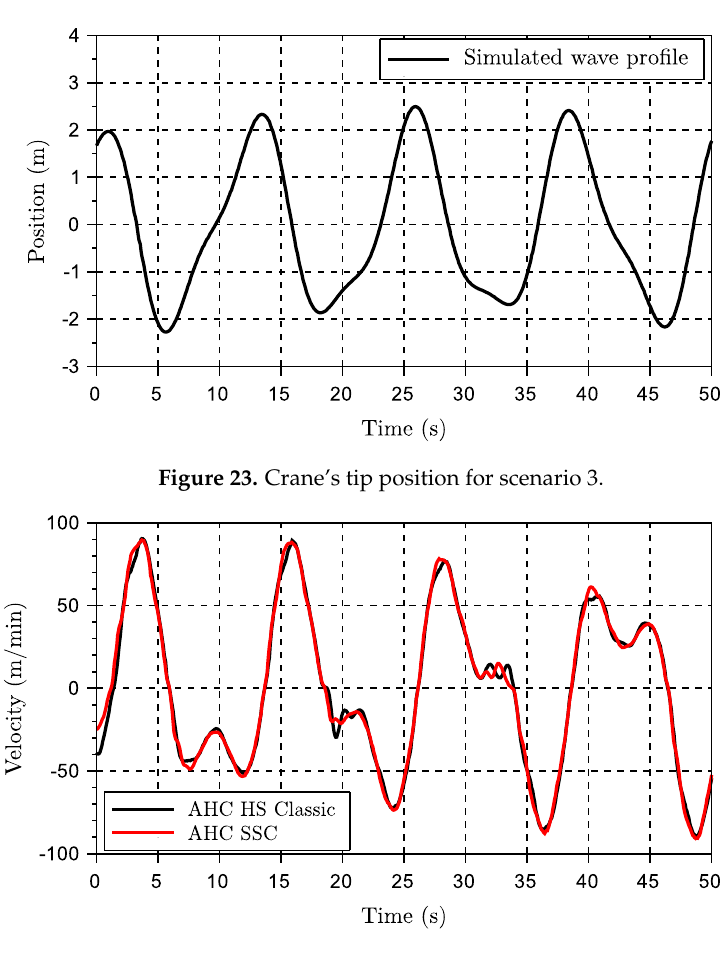
Figure 24. Wire velocities for scenario